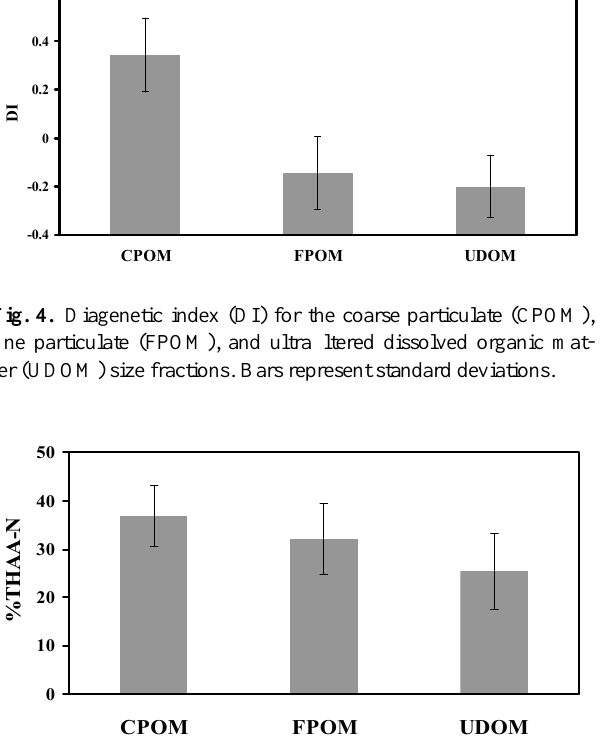
Fig. 5 Fig. 5. Spatial-averaged percentages of total nitrogen (N) as total hydrolysable amino acids (THAA) for the coarse particulate organic matter (CPOM), fine particulate organic matter (FPOM), and ultra- filtered dissolved organic matter (UDOM) size fractions based on values at the 13 sampling stations. Bars represent standard devia-